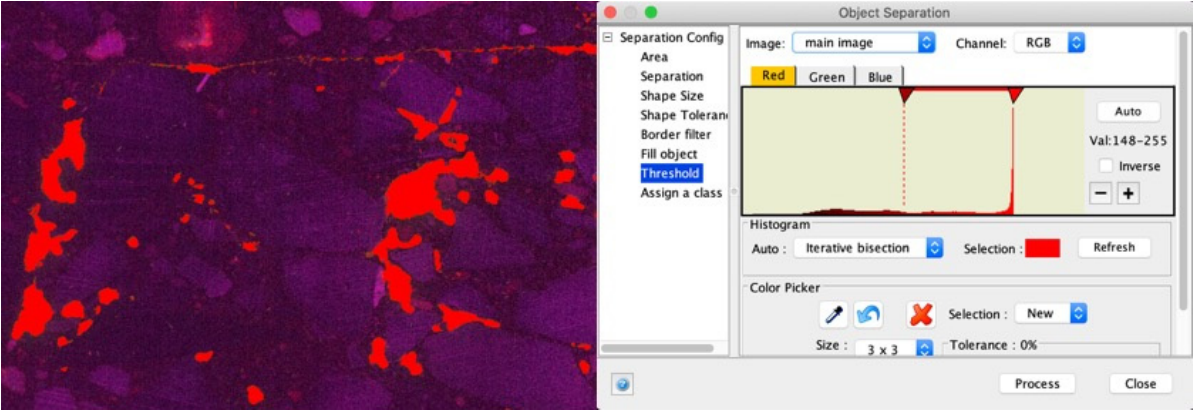
Figure 3. Identification of air voids using pixel-based segmentation.